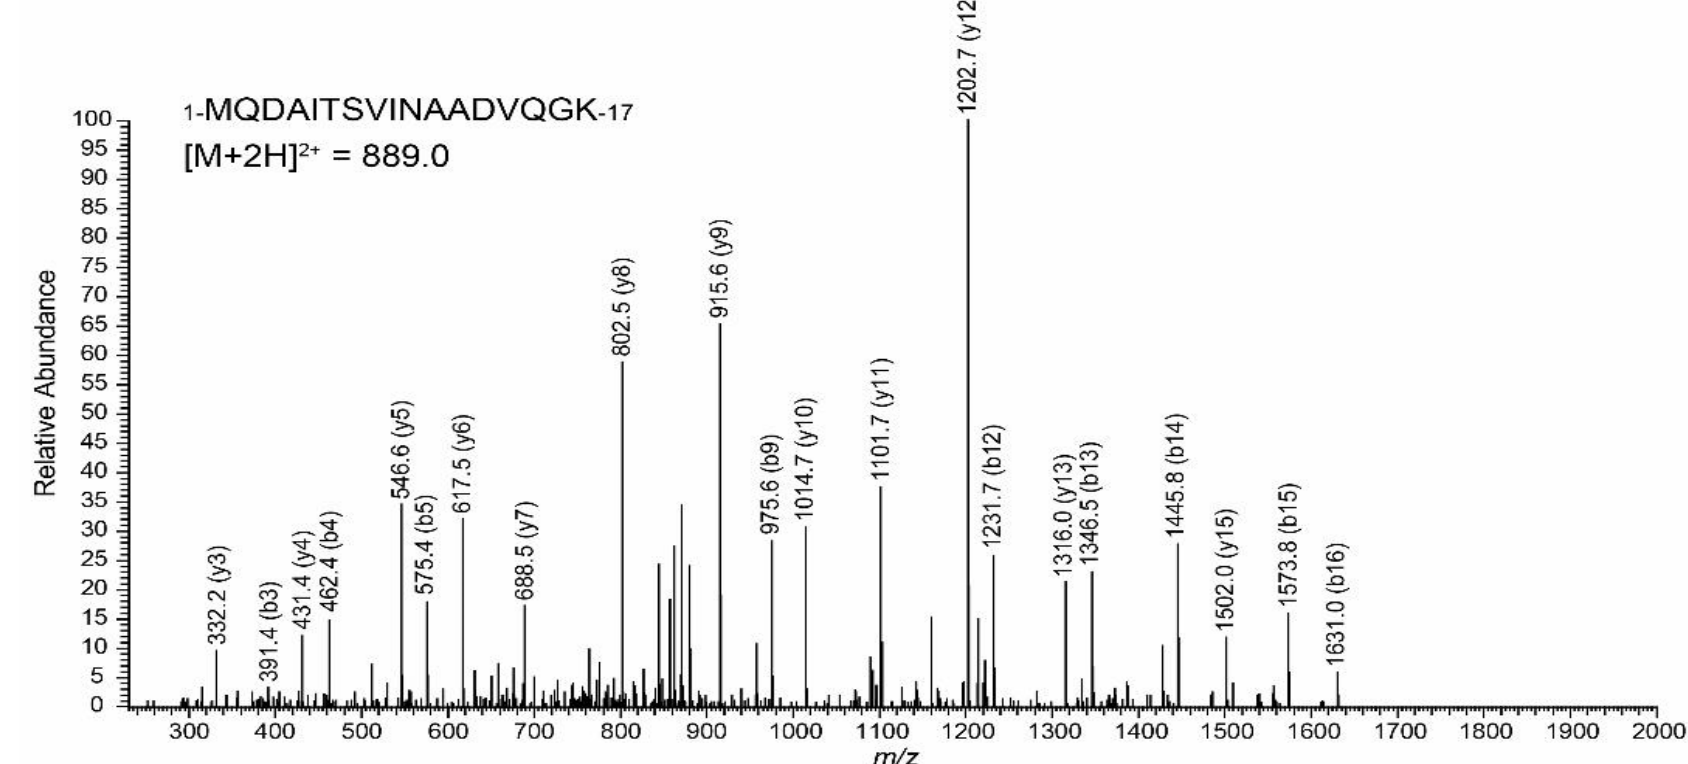
Figure 5. Identification of molecular mass and amino acid sequence of the purified peptide (fraction A4) by LC-MS/MS.